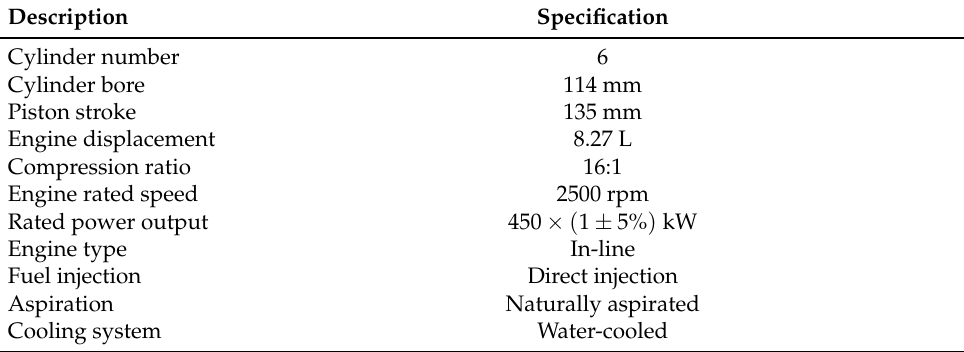
Table 1. Specifications of the diesel engine considered in this